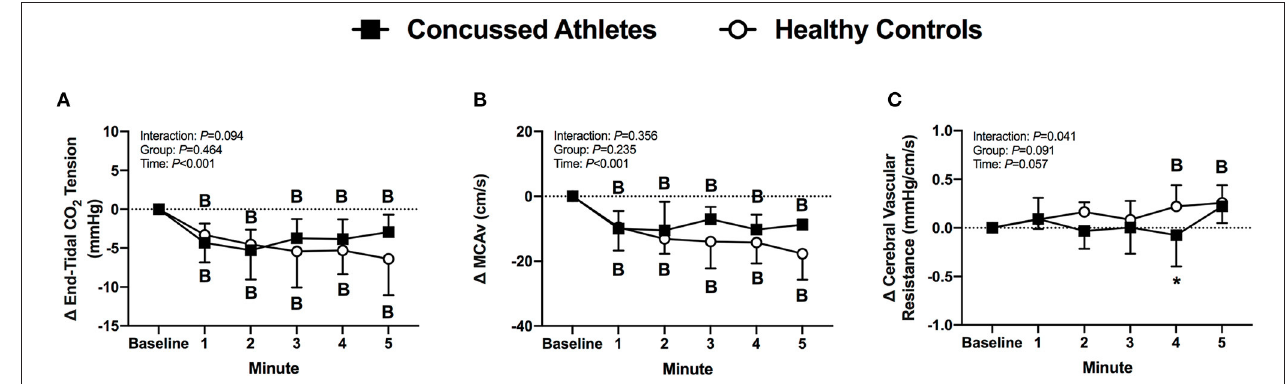
FIGURE 3 | The change from baseline in end-tidal CO 2 tension (A) , MCAv (B) and cerebral vascular resistance (C) at each minute of LBNP for concussed athletes ( n = 10) and healthy controls ( n = 9; one excluded due to poor TCD signal). Participants who experienced pre-syncopal signs and did not last the full minute are not included in the statistics for that time point. Concussed athletes were excluded at 3min ( n = 4), 4min ( n = 5), and 5min ( n = 7). Healthy controls were excluded at 3min ( n = 1) and 4min ( n = 2). B, different from Baseline ( P ≤ 0.05). *Different from Healthy Controls ( P ≤ 0.05).